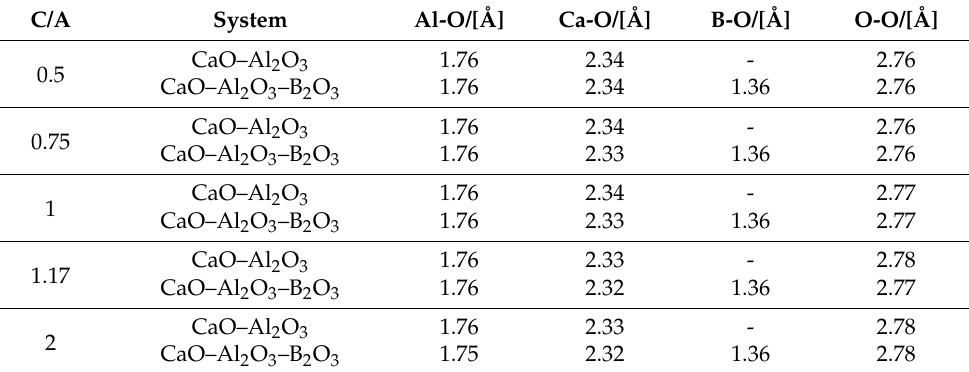
Table 4. Bond length of different particle pairs with different CaO/Al 2 O 3 mole ratio systems in this